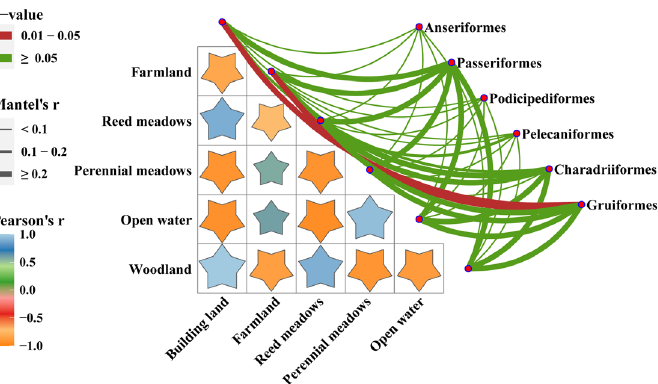
Figure 8. Correlation between orders and habitat types by Mantel test. Pearson’s r represents the correlation coefficients among different habitat types; Mantel’s r reveals the correlation coefficients between ecotypes and habitat types, and the thicker the line is, the larger the correlation coefficients are; p -value represents the significance of the correlation between ecotypes and habitat types.